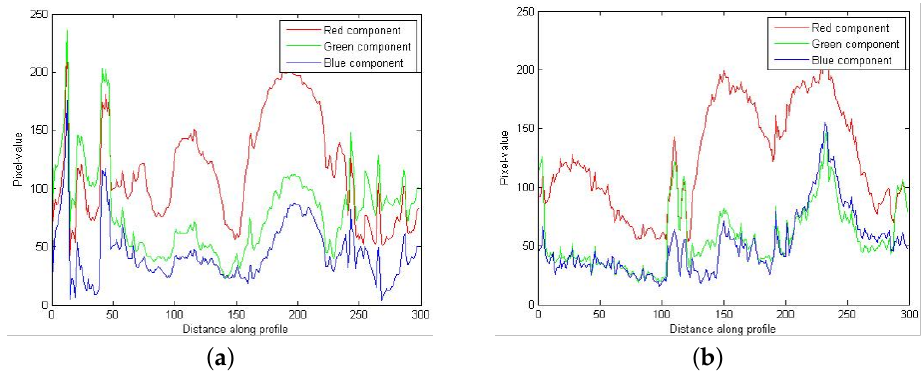
Figure 5. Cross-sectional pixel values. ( a , b ) represent different cross-sectional pixel values of two long jujubes.